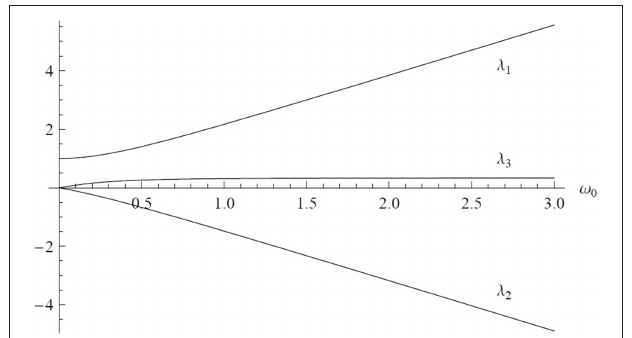
FIGURE 5 | Eigenvalues λ 1 , λ 2 , λ 3 , of (cid:127)